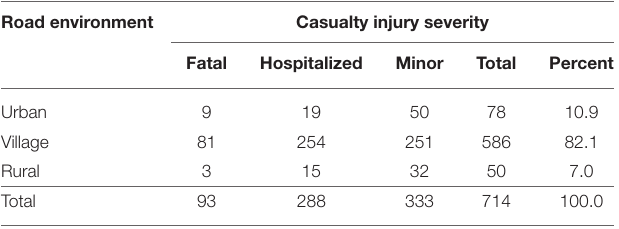
TABLE 5 | Casualty distribution by road environment on Abuakwa-Bibiani Highway. Road